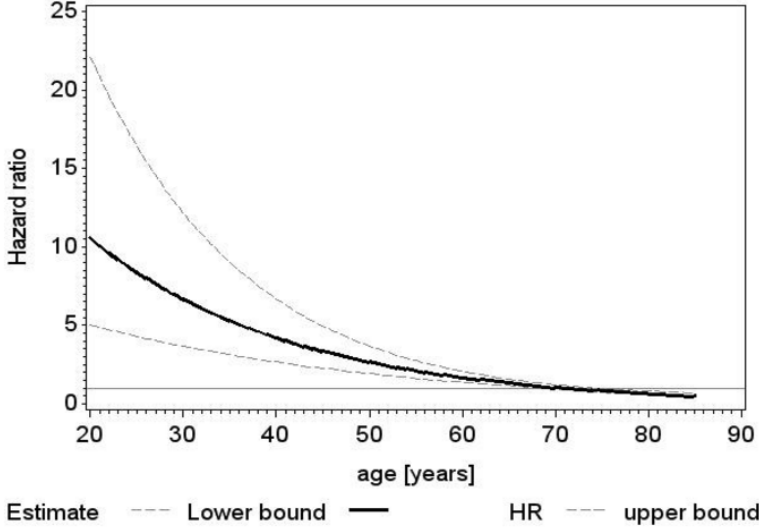
Figure 3. Recipients of biological prostheses compared with recipients of mechanical valves in terms of death, plotted against age as a continuous variable (black line).